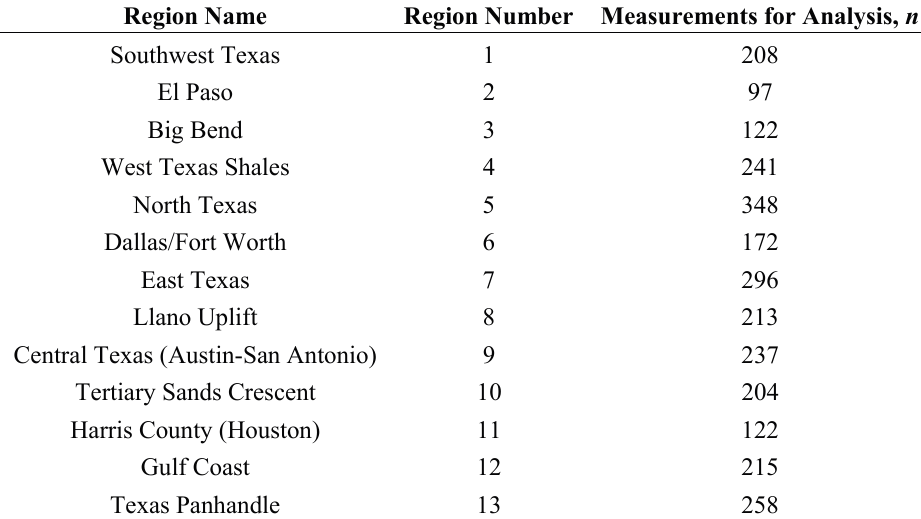
Table 1. Description of the thirteen study regions of the The Texas Indoor Radon Survey, 1991. Region Name Region Number Measurements for Analysis,